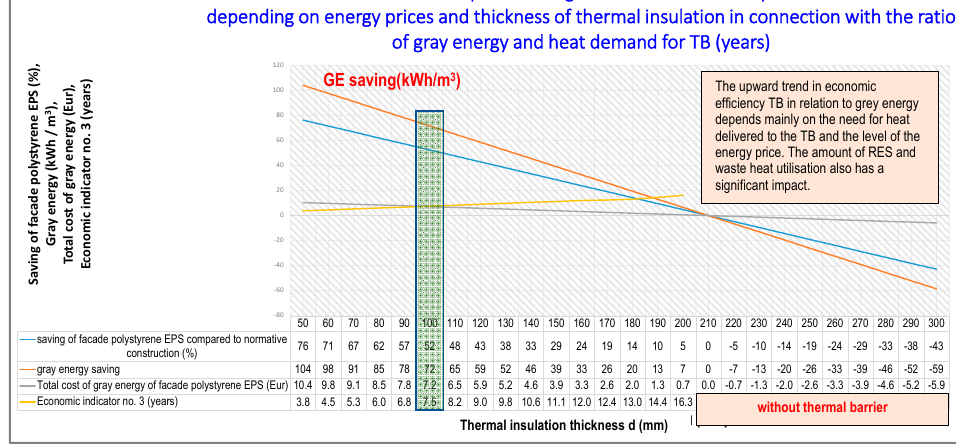
Figure 16. Dependence of economic indicator No. 3.